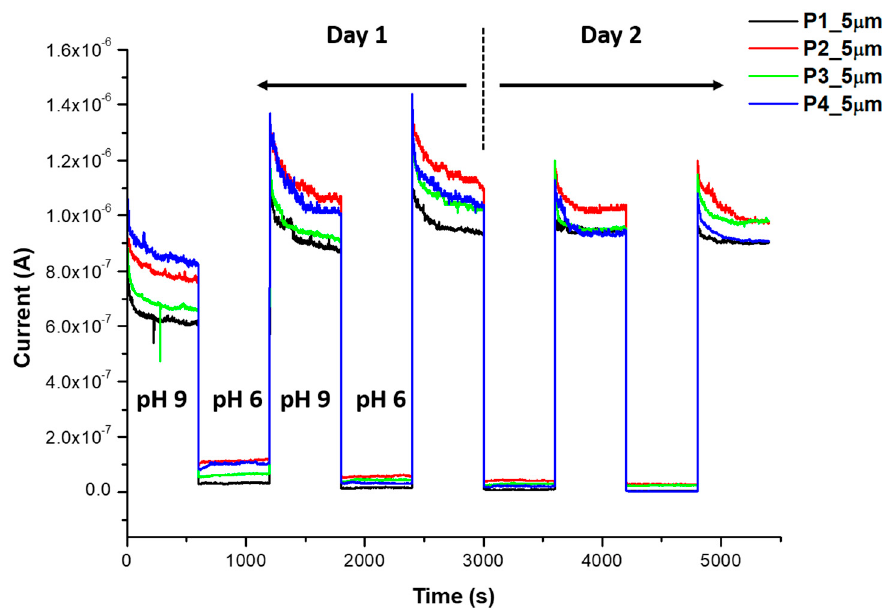
Figure A5. Real-time measured drain current of p-CNTFETs sweeping between pH 9 an pH 6 in PBS. The channel length of measured p-CNTFETs is 5 µ m. Gate voltage (V gs ) is fixed at − 0.8 V and a drain voltage (V ds ) is fixed at +0.8 V.